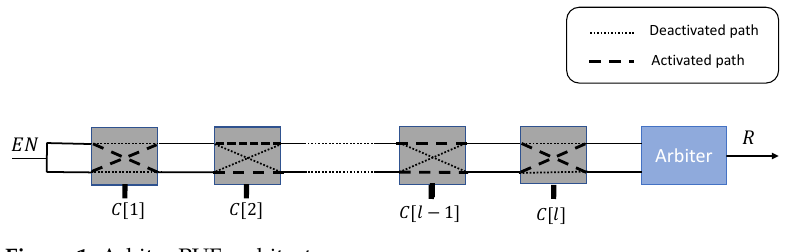
Figure 1. Arbiter PUF